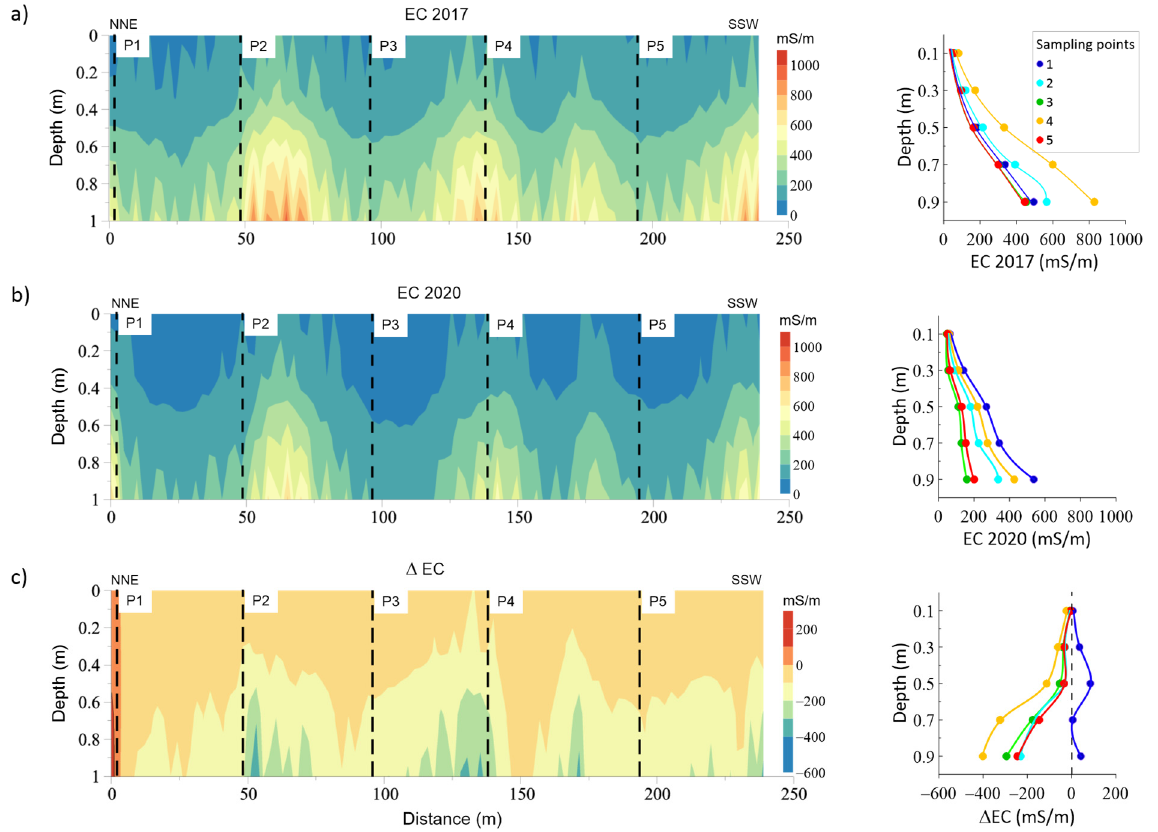
Figure 6. Images of inverted ECa (EC) along the transect for ( a ) 2017; ( b ) 2020; and ( c ) increments of EC between 2017 and 2020 ( Δ EC).